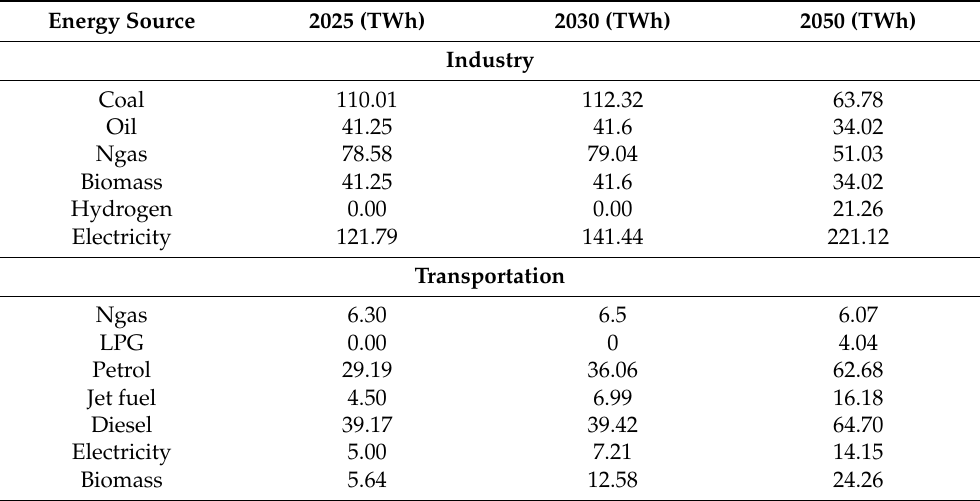
Table 6. Different sources of energy consumption in transportation and industry sectors in the future scenarios.